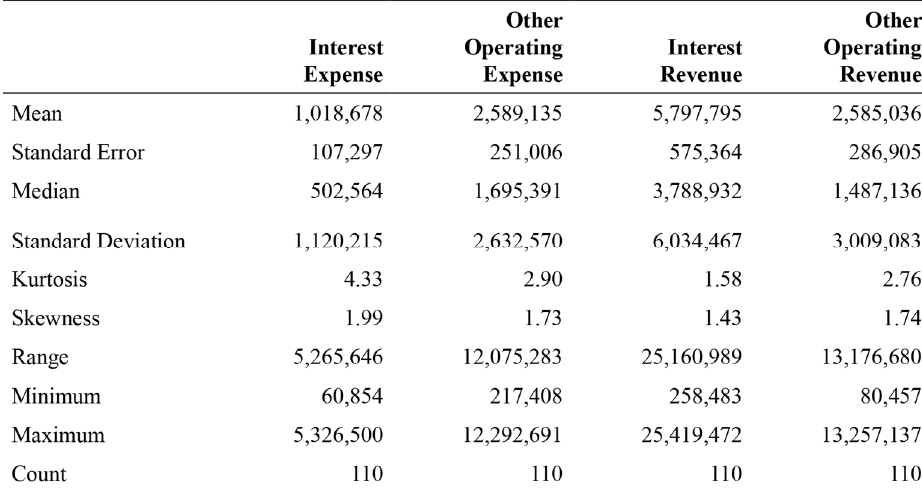
Figure A4. Summary statistics.